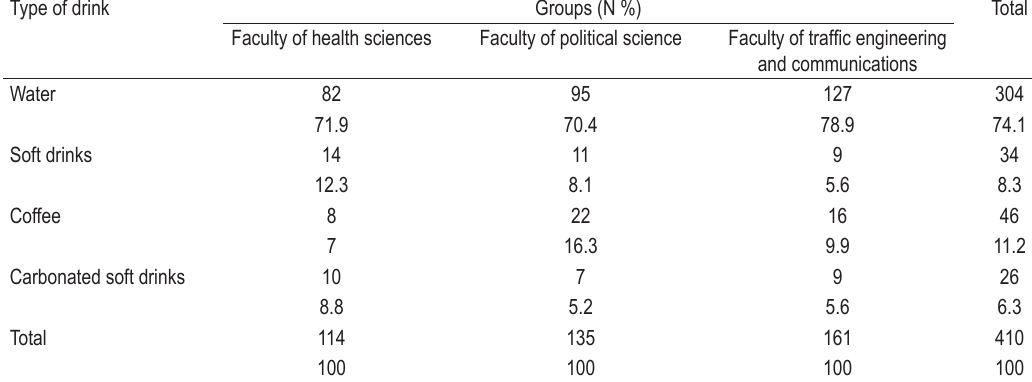
TABLE 8. Drink choices of students in three groups Type of drink Groups (N